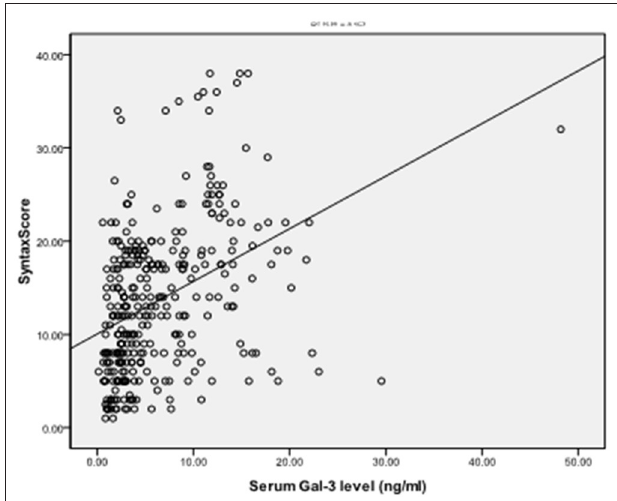
FIGURE 2 | Positive correlation of serum Gal-3 with Syntax Score (SS), r = 0.397, P <